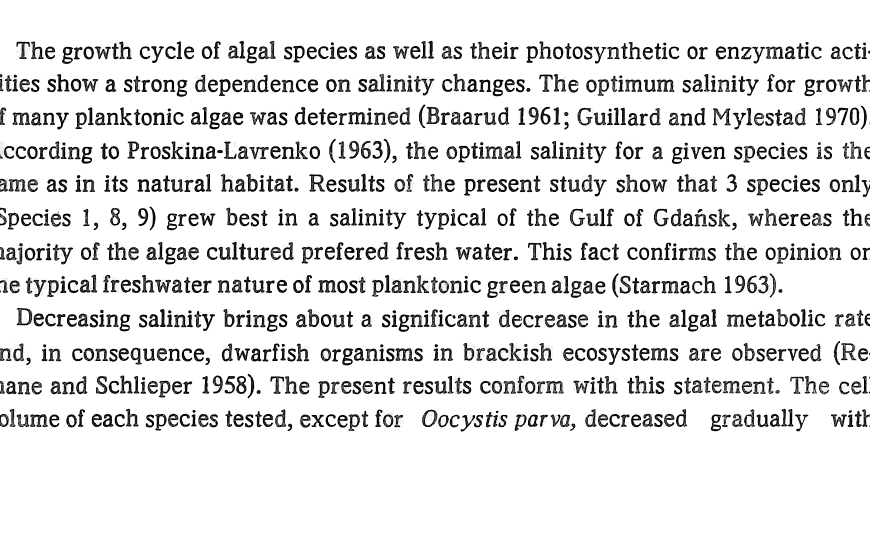
Fig. 10. The plot of regression between light intensity and cell volume of Oocystis parva, together with measured values. Dotted lines represent confidence and prediction